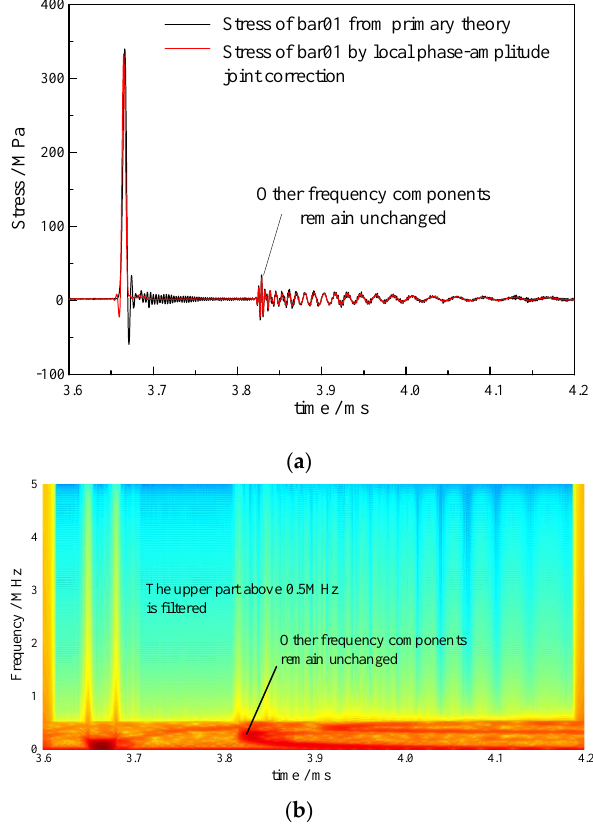
Figure 15. The result of the first order mode local phase-amplitude joint correction of bar 0 1′ s free surface velocity ( a ) Comparison of corrected stress curve with elementary theory stress curve; ( b ) Time-frequency joint spectrum of corrected stress curve. Appl. Sci. 2020 , 10 , x